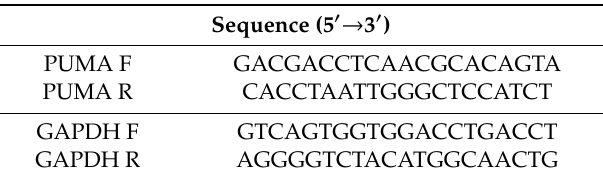
Table 1. Primer sequences used for